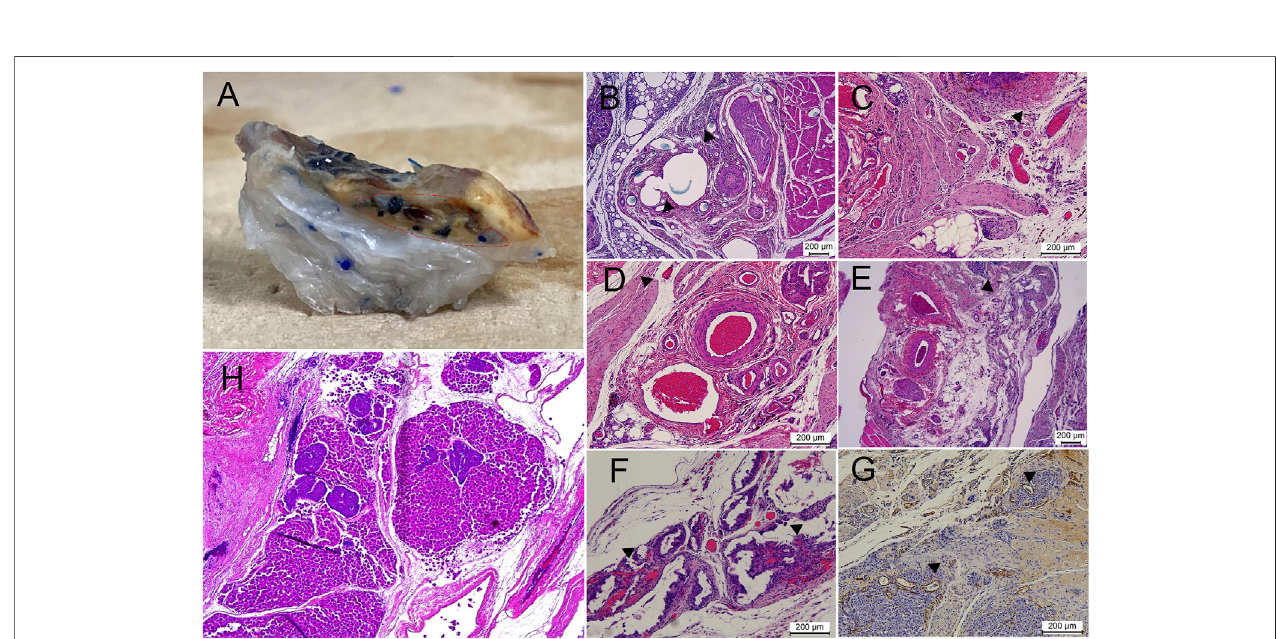
FIGURE 10 | Vascularity of the implanted scaffold at the end of the study. (A) Large vessels inside the scaffold, shown by injection of colored dye (region encircled by dashed red line). B-G) Different patterns of vascularization seen on a histological examination, with the following fi ndings marked with black arrowheads: (B) direct sproutingfromthemainveinoftheAVbundle, (C) vesselsobservedinsidethescaffoldincloseassociationwiththeAVbundle, (D,E) sproutingofvesselsalongthenative scaffoldinferiorvenacavatributaries, (F) remarkableintra-scaffoldvascularizationinassociationwithscaffoldresorptionregions, (G) anti-Von-Willebrandstainingof neovascularization inside the islet graft. (H) Day 0 specimen after combined injection of both pancreatic islets and hepatocytes; islets frequently failed to reach the intra- scaffold location compared with smaller hepatocytes.